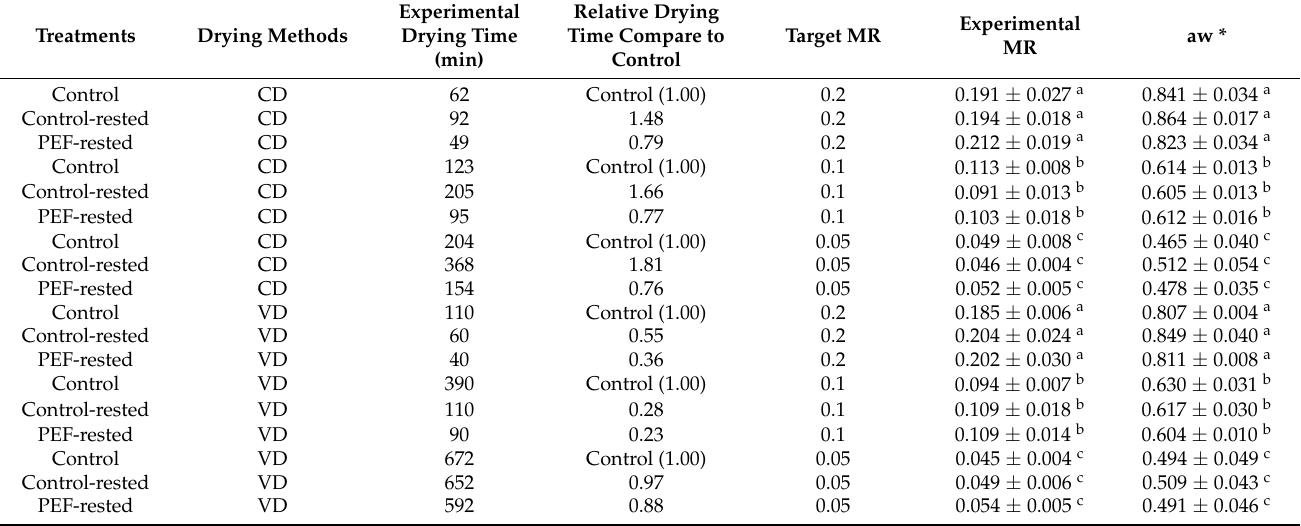
Table 1. Experimental drying time, moisture ratio (MR), and water activity (aw) of Thai basil leaves samples treated with different treatments (control, control-rested, and PEF-rested). Data are shown as average ± standard deviation of the mean for n = 3 and different letters denote significant differences at p < 0.05.